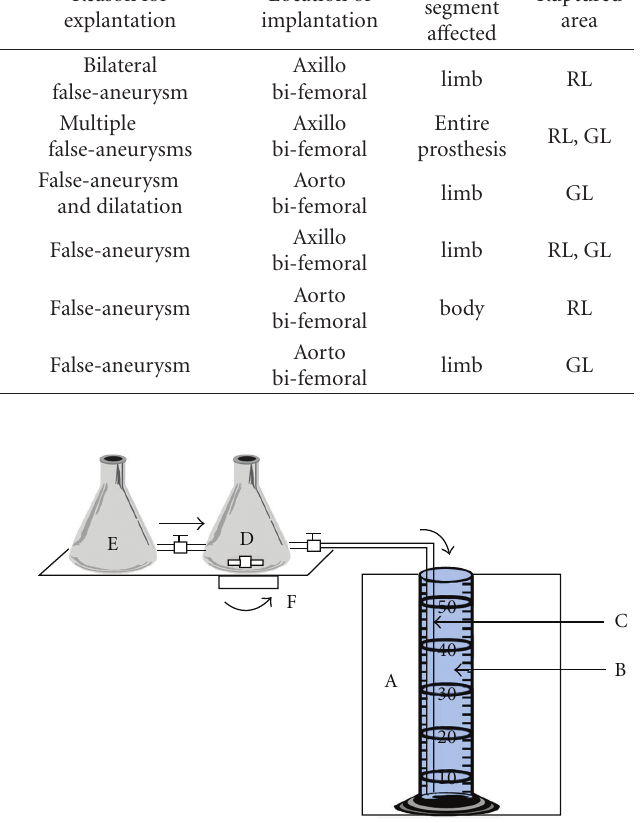
Figure 5: Experimental representation of the gradient density column. A: temperature controlled chamber; B: column of gradient density; C: capillary tubing; D: carbon tetrachloride solution; E: petroleum ether solution; F: magnetic